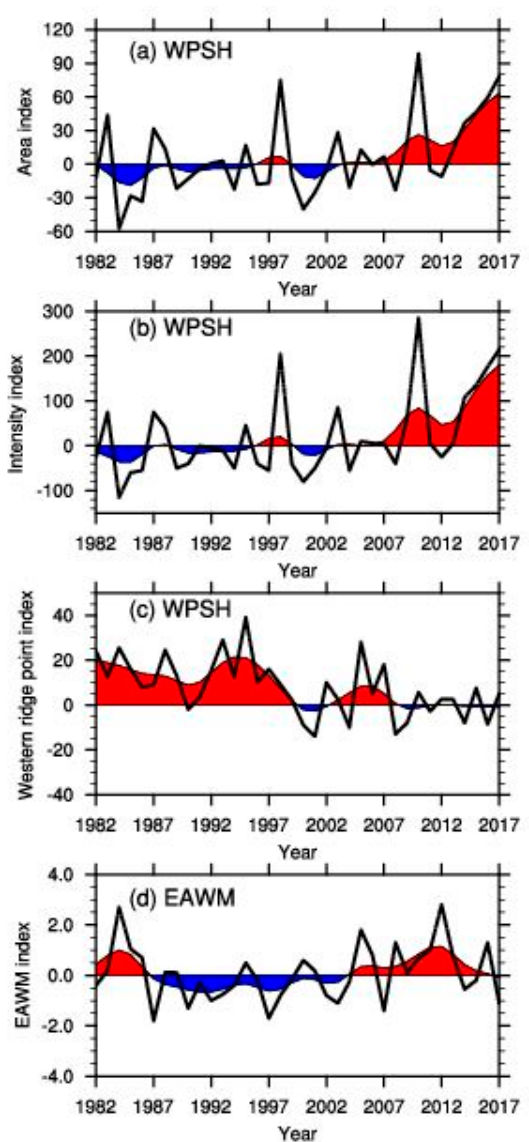
Figure 4. Time series of summer mean (black lines) and 9 year running mean (shaded lines) indices from 1982–2017 of the west Pacific subtropical high (WPSH): area ( a ), intensity ( b ), westward extension ( c ), and time series of the East Asia winter monsoon Index ( d ). Data are all from the Chinese National Climate Center (CNCC).